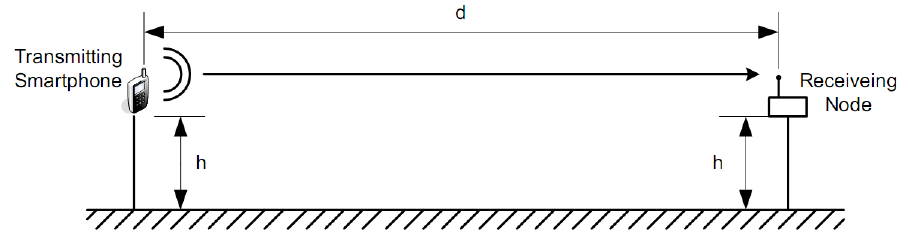
Figure 8. Measurement setup for determining the wake-up